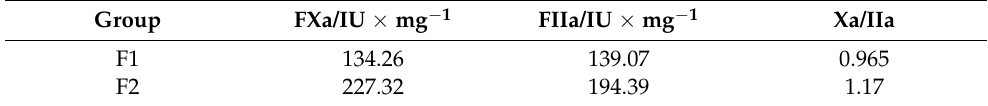
Figure 5. Analysis of APTT ( A ), TT ( B ) and PT ( C ) of F1 and F2. The anticoagulant potentials of two heparinoids derived from shrimp heads were investigated. As shown in Table 4, the anti-FXa activity, anti-FIIa activity and anti-FXa/anti-FIIa ratio of F1 were 134.26 IU/mg, 139.07 IU/mg and 0.965, respectively, while the anti-FXa activity, anti-FIIa activity and anti-FXa/anti-FIIa ratio of F2 were 227.32 IU/mg, 194.39 IU/mg and 1.17, respectively. As the concentration of heparinoid F1 and F2 increased, more AT-III was activated, which resulted in more Xa, IIa binding to AT-III and eventually inactivation. The above results indicated that the anticoagulant effect of heparinoid F1 and F2 is partly consistent with the anticoagulant mechanism of heparin. At the same time, the acceleration of F1 and F2 on the inactivation of thrombin and coagulation factors through AT-III is also a potential mechanism. Gomes et al. [7] examined the anti- coagulant activity of heparin derived from porcine intestinal mucosa and bovine intestinal mucosa and found that there were significant differences in anticoagulant activity among them. Bovine heparin exhibited anti-FXa and anti-FIIa activities of 92.2 IU/mg and 88.1 IU/mg, with a ratio of 1.04, while the anti-FXa and anti-FIIa activities of porcine heparin were 204.6 IU/mg and 216.2 IU/mg, with a ratio of 0.98. Bovine heparin requires twice the dose of porcine heparin to achieve the same anticoagulant effect, implying that heparin from different sources significantly differed in activity. Table 4. Anti-Xa factor and IIa factor analysis of F1 and F2.